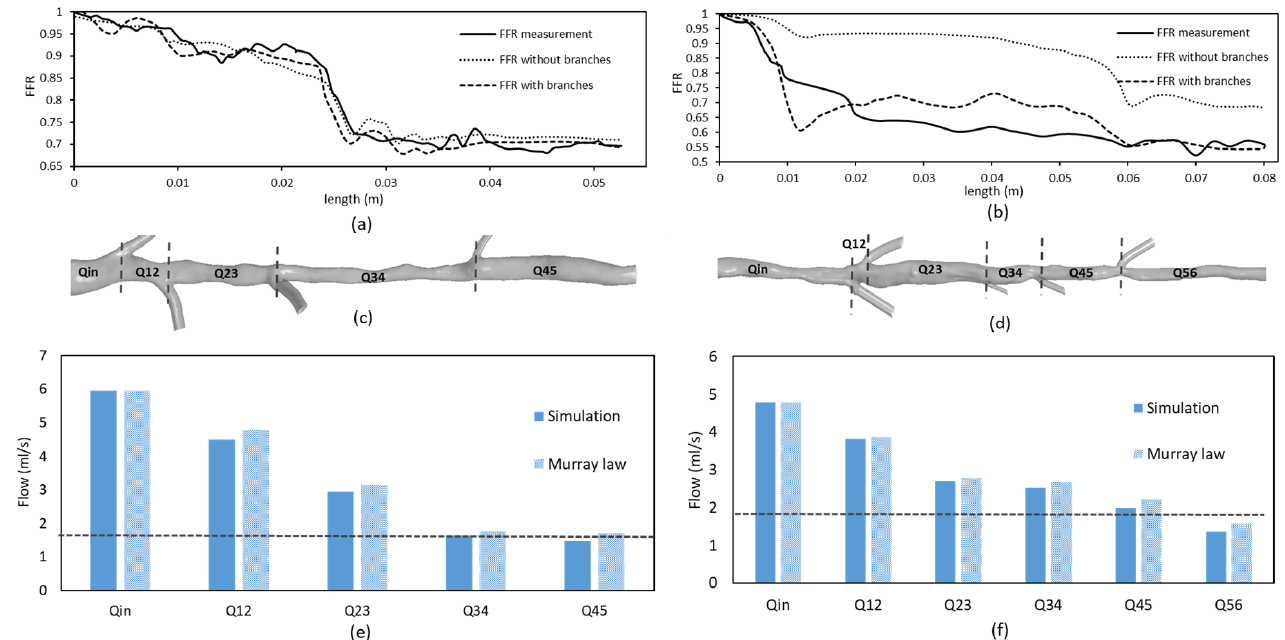
Figure 7. FFR variation in the main vessel compared with guidewire measurements for ( a ) patient 1 and ( b ) patient 2. Flow across the different sections (denoted in ( c , d )) of the main vessel of ( e ) patient 1 and ( f ) patient 2 compared with the flow distribution derived from Murray’s law. The flowrates in the models without side branches are indicated with dashed horizontal lines in ( e , f ).